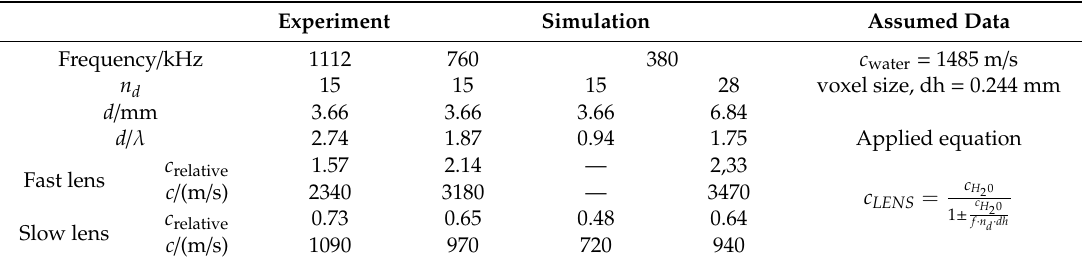
Table 2. Recommended p-wave speeds and nominal lens thicknesses, d , for the experiment and simulation frequencies, assuming that the number of voxels associated with the ideal nominal thickness value, n d , is 15. The last column shows the minimal value of n d that can be achieved by the fastest polymer listed in Table